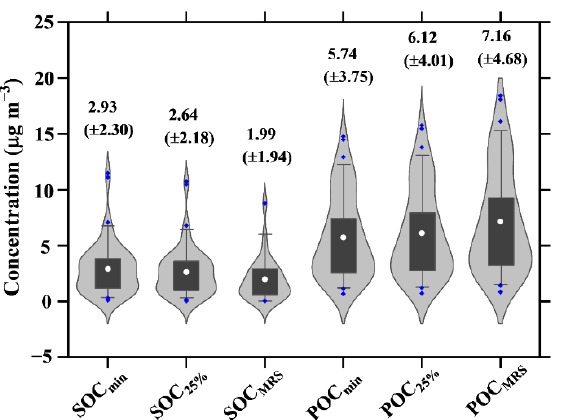
Figure 3. SOC and POC concentration (violin plots) at Nainital using the minimum, 25th percentile, and MRS method. The box shows the 25–75th percentiles, while the open circle corresponds to the mean, which was given in the graph along with the standard deviation (whiskers).